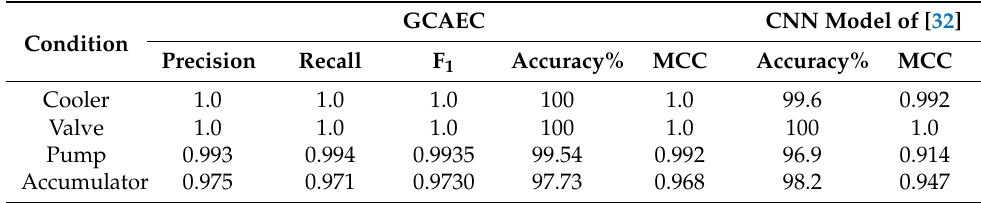
Table 3. Performance comparison results for the classification of 4 fault types by our GCAEC model and the CNN model [32] on ZeMA dataset for 60-s records.